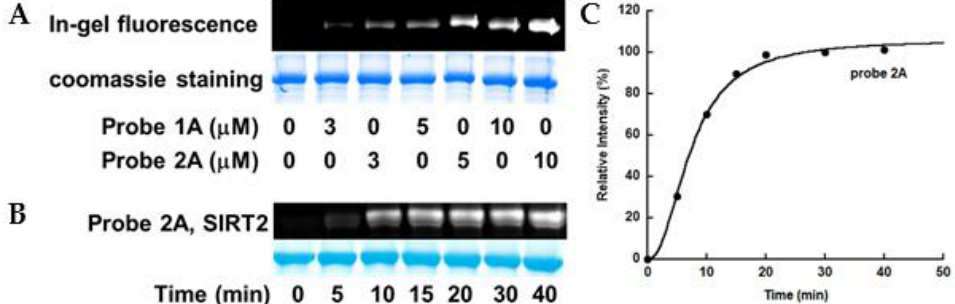
Figure 3. Comparison of labeling efficiencies of probes 1A and 2A. ( A ) Concentration-dependent labeling of SIRT2. SIRT2 (10 µ M) was incubated with 500 µ M NAD + and indicated concentrations of probe 1A or 2A in 100 mM phosphate buffer pH 7.5. The samples were incubated at 37 °C for 10 min, subjected to UV irradiation for 1 h, and then “click” conjugated to TAMRA-azide as described in “Materials and Methods”; ( B ) and ( C ) Time-dependent labeling of SIRT2 by probe 2A. The labeling reached plateau within 20 min.